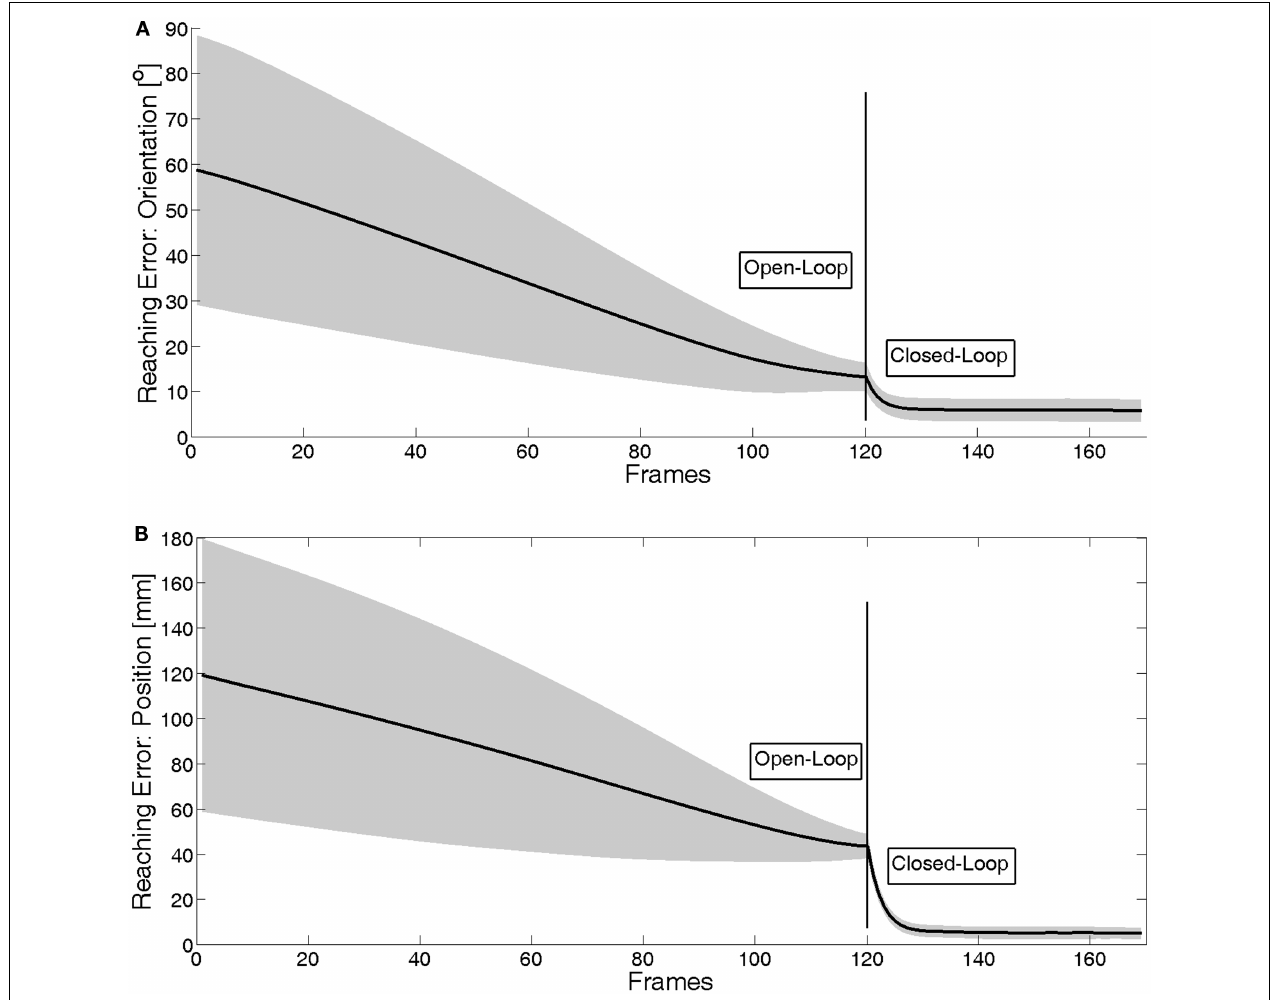
FIGURE 7 | Real reaching error during the whole movement: (A) orientation and (B) position . The error is the average over 120 experiments: 4 different final poses, 10 different initial poses and each movement is repeated three times. It can be seen how the closed-loop correction considerably reduces the reaching error.